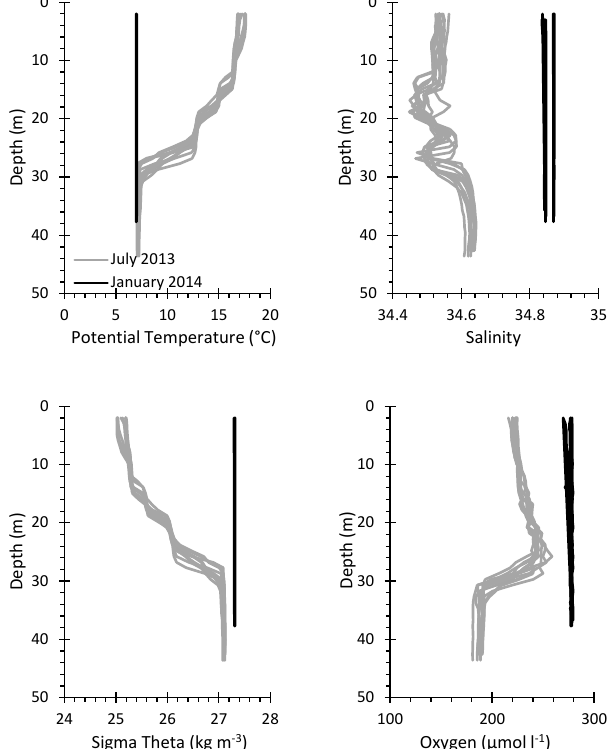
Figure 3. Depth profiles of potential temperature, salinity, density (sigma theta), and oxygen for all stations in both summer and winter field